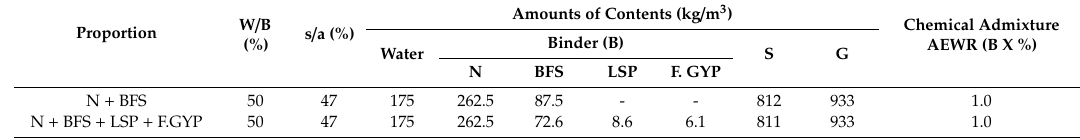
Table 3. Concrete mix